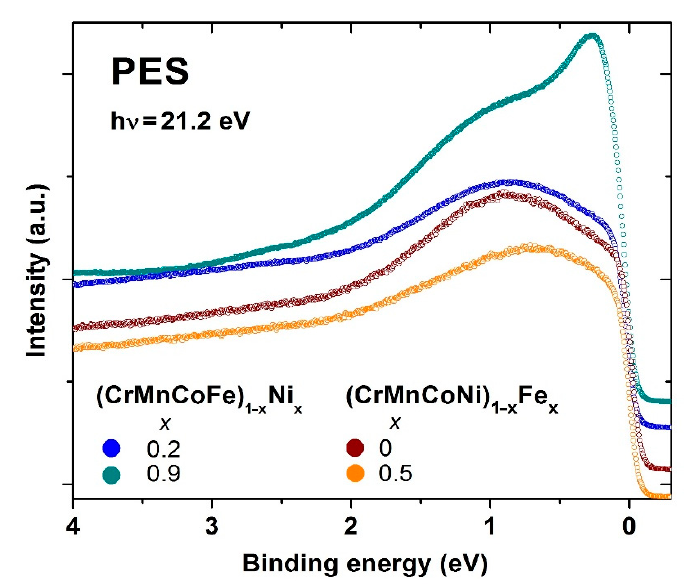
Figure 14. Photoemission spectra of selected (CrMnFeCo) 1 − x Ni x and (CrMnCoNi) 1 − x Fe x alloys. Spectra are displaced upwards for clarity.